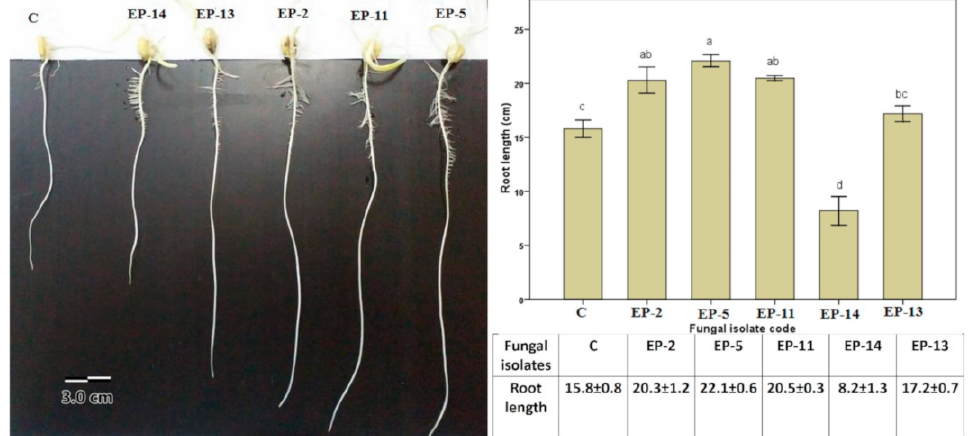
Figure 3. Effect of endophytic fungi as bioinoculant on root length of Zea mays L. Error bars are ± SE ( n = 5). Different letters (a, b, c, and d) on bars denote that mean values are significantly different ( p ≤ 0.05) by the Tukey LSD